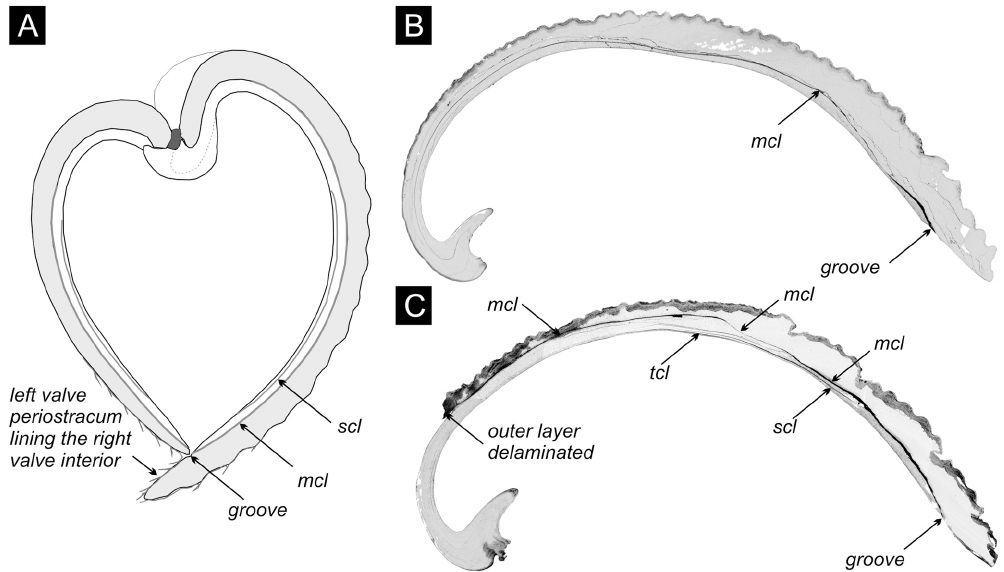
Figure 4. (a) The cross section of the articulated shell of V. gibba , adapted from Lewy and Samtleben (1979), shows that the internal conchiolin layer (mcl) separates both valves into an inner and an outer layer, and the inner layer can contain another secondary conchiolin layer (scl). The left valve fits into a groove with the conchiolin layer on the interior of the right valve. Periostracum on the left valve extends beyond its length and covers the interior of the right valve. (b) The section through the right valve with a 10–100µm thick cavity (in black) initially filled by the single (main) conchiolin layer. Po 3 (core M14) at 40–45cm. (c) The section through the right valve with 10–100µm thick cavities present within the main and other conchiolin layers (mcl – main conchiolin layer, scl – secondary conchiolin layer, tcl - tertiary conchiolin layer). Po 3 (core M13) at